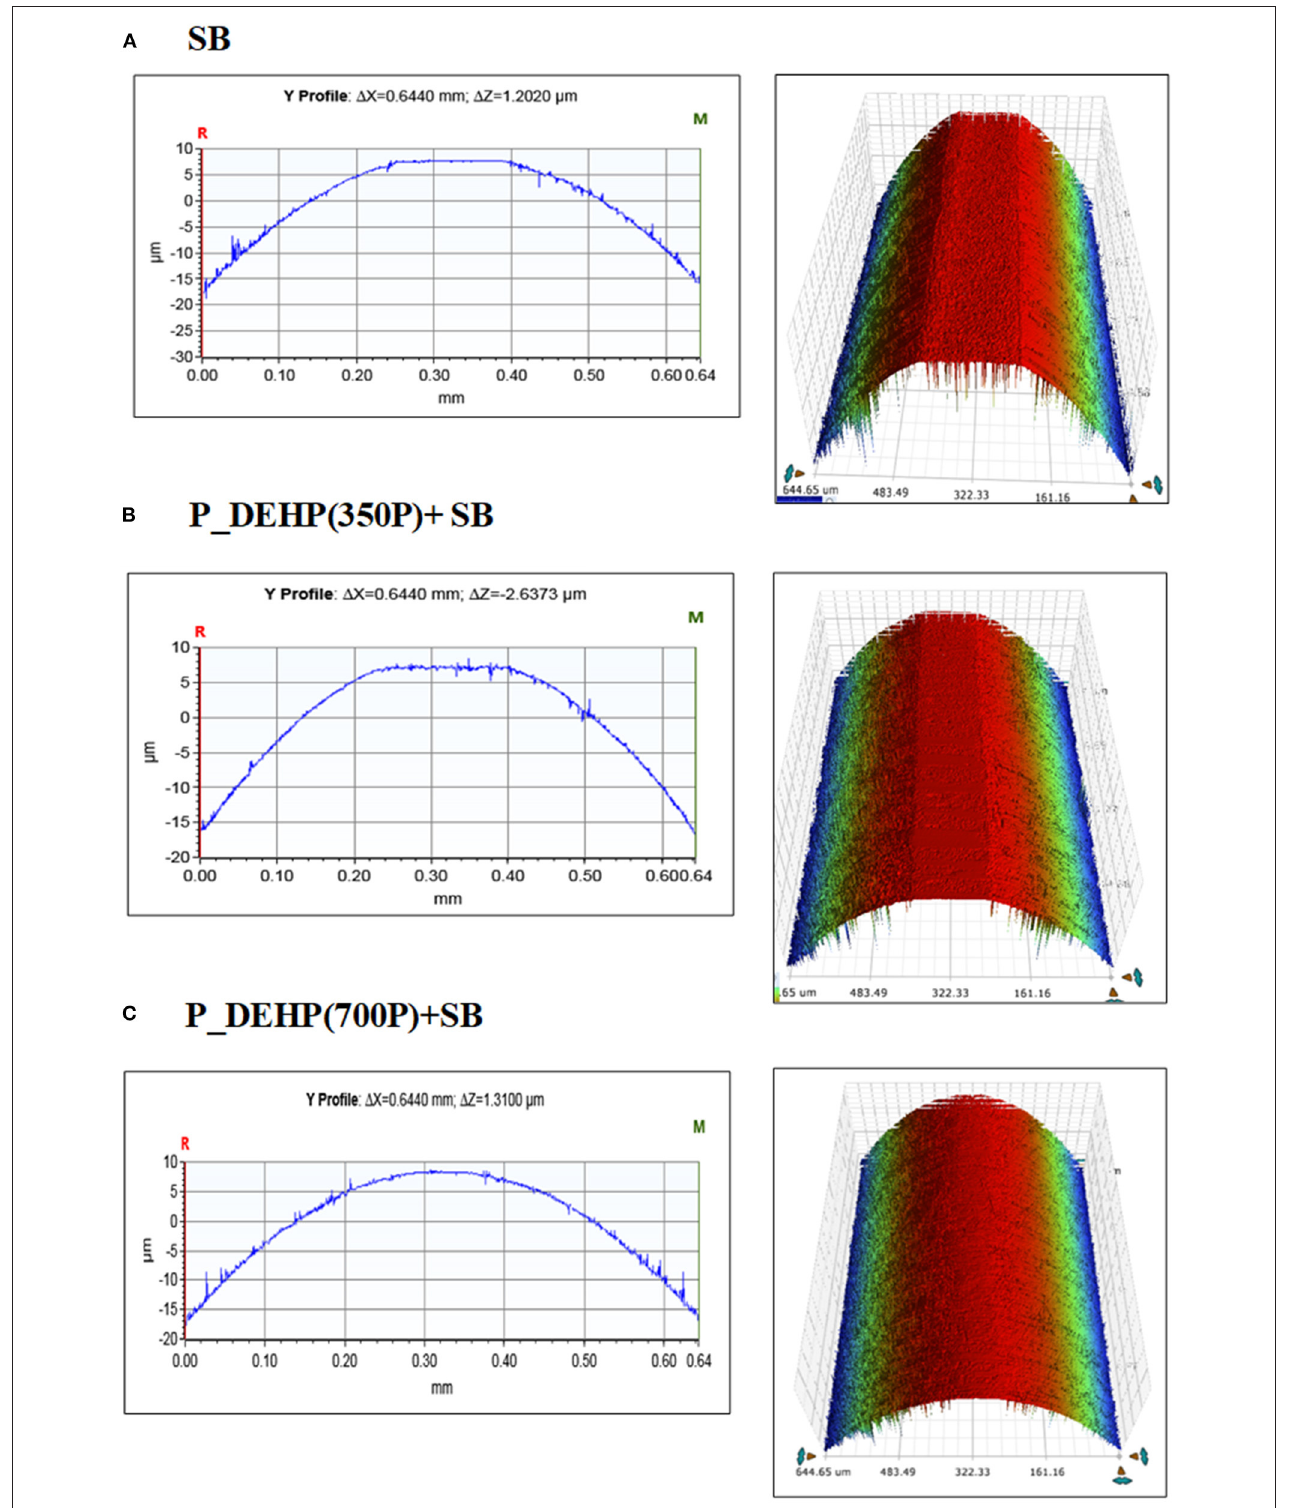
FIGURE 5 | Optical profilometry images of the cylinders represented in 2D (left) at the center region of the cylinder and the 3D representation of the wear scar developed after 1h (A) SB, (B) P_DEHP(350P) + SB, (C) P_DEHP(700P) + SB tribological tests.